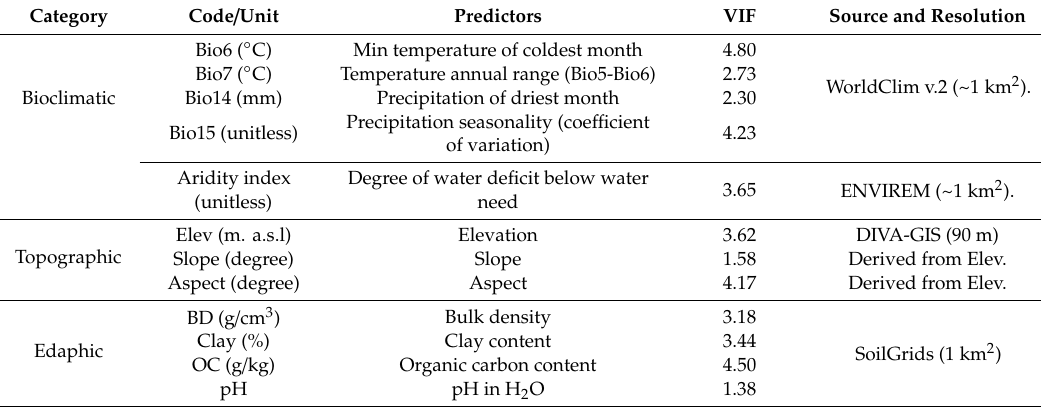
Table 3. The environmental predictors used in the habitat suitability modeling for P. boveana with their variance inflation factors (VIFs < 5). Units were reported for dimensional